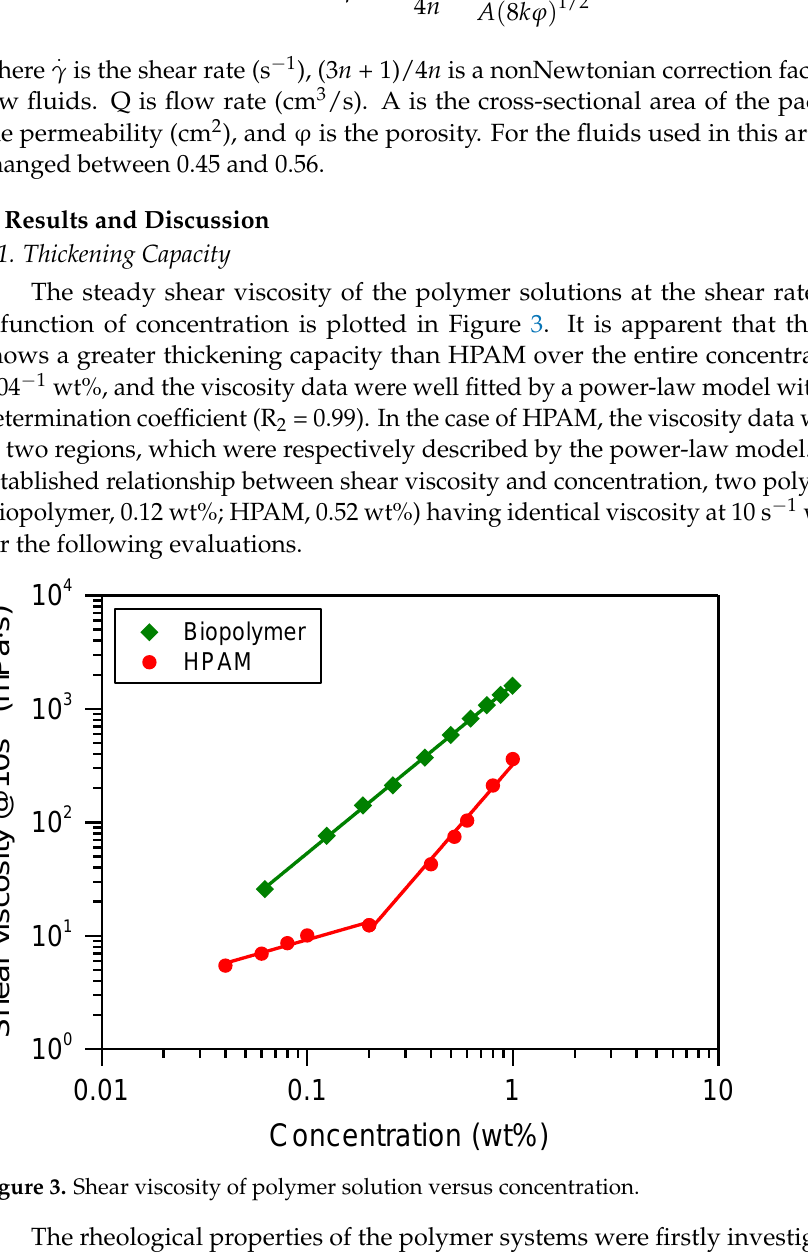
Table 2. Plug Parameters of Core Flood Tests.